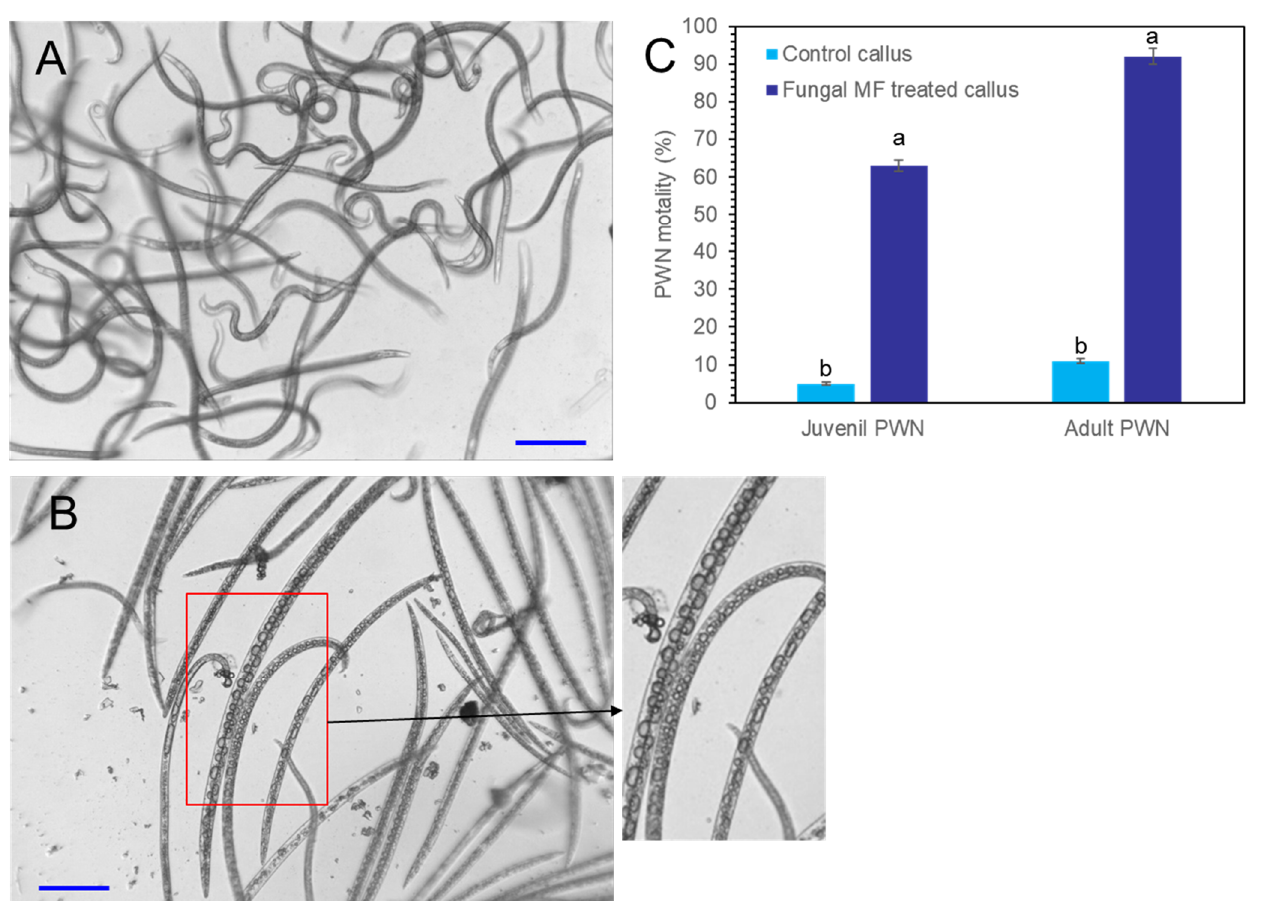
Figure 10. Photographs of PWN mobility and nematicidal effects of P. koraiensis cell extracts with and without fungal elicitor ( P. chrysogenum MF) treatment. ( A ) PWNs with active mobility after 24 h of incubation in control P. koraiensis cell extracts. ( B ) PWNs with immobilized strait dead body shapes after 24 h of incubation in P. koraiensis cell extracts after fungal elicitor treatment for 3 days. ( C ) The concentrations of DPME and PME in P. koraiensis cell extracts were adjusted to 11 µg/mL and 200 µg/mL, respectively. Different letters above the bars indicate significantly different values ( p < 0.05), calculated using one-way ANOVA followed by Duncan's post hoc analysis . Scale bars = 100 µm.